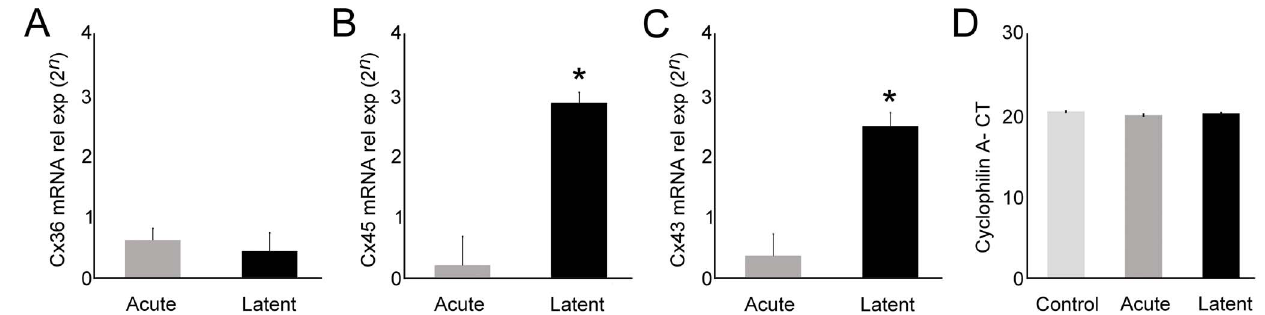
Figure 3. Gene expression levels of Cxs in the rat hippocampus during acute and latent periods. (A) Cx36 gene expression remains stable throughout acute and latent periods. (B) On the other hand, we were not able to detect changes in Cx45 transcript levels in acute period, although increased expression was observed in the latent group. (C) Similar results were observed for Cx43 mRNA levels, since we were not able to detect significant differences in the acute group, but we found increased expression in the latent group when compared to controls. (D) Gene expression of cyclophilin A was used as internal control. Means from acute (n=8) and latent (n=8) groups were normalized based on control group (n=8) expression levels. Bars represent standard errors of mean. * P , 0.001 vs . Control group in Tukey’s HSD pairwise comparisons after one-way